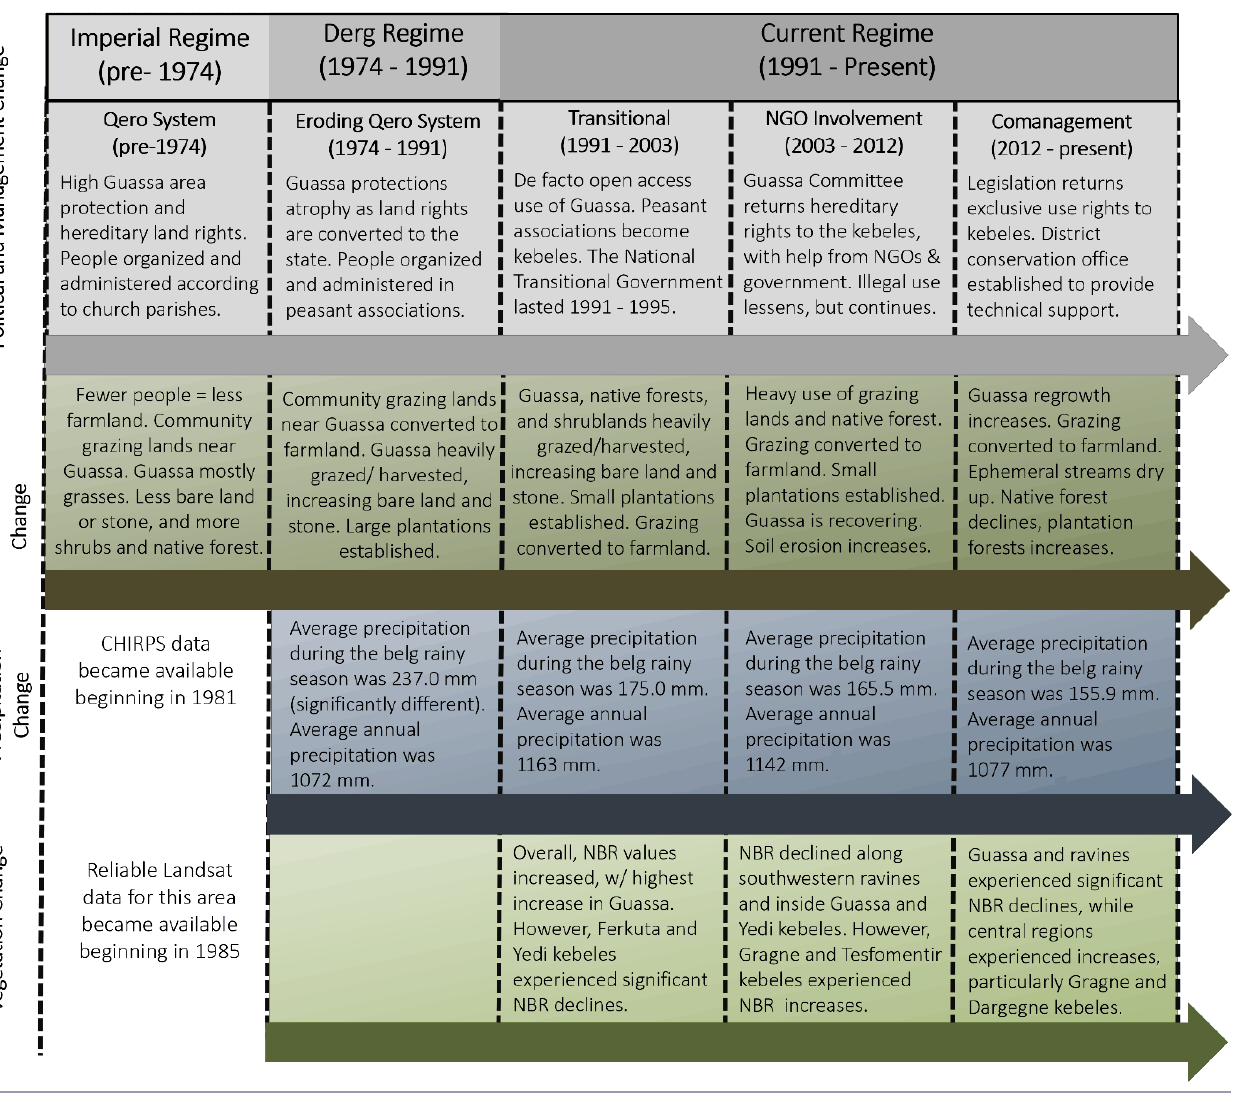
Fig. 6 . Timeline of change across multiple data